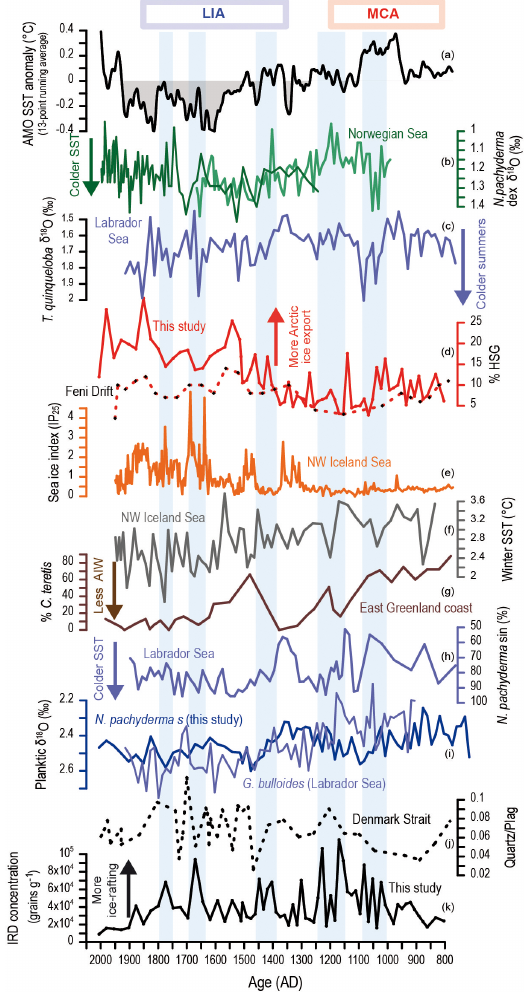
Figure 4. Comparison of IRD records from site GS06-144-03 with subpolar North Atlantic records of sea surface temperature, ice raft- ing and sea ice. (a) Atlantic Multidecadal Oscillation (AMO) SST anomaly (Mann et al., 2009); (b) N. pachyderma dex δ 18 O record from the Norwegian Sea (Sejrup et al., 2010); (c) T. quinqueloba δ 18 O record from site RAPiD-35-25B at Eirik Drift; (d) HSG rela- tive abundance from site GS06-144-03 (solid line, this study) and from Feni Drift (dashed line; Bond et al., 2001); (e) sea ice in- dex (IP25) from site MD99-2275, NW of Iceland (Massé et al., 2008); (f) diatom-based winter SST from site MD99-2275 (Jiang et al., 2007); (g) relative abundance of the Atlantic waters indica- tor Cassidulina teretis from Nansen Fjord (Jennings and Weiner, 1996); (h) relative abundance of N. pachyderma sin from Eirik Drift (Moffa-Sanchez et al., 2014b); (i) planktic foraminifer δ 18 O from Eirik Drift ( G. bulloides from Moffa-Sanchez et al., 2014a; N. pachyderma sin from this study); (j) quartz vs. plagioclase ratio, a proxy for ice rafting, from MD99-2263 (Andrews et al., 2009); and (k) total IRD concentration from site GS06-144-03 (this study). Light-blue vertical bars indicate the periods in which IRD concen- tration is higher at site